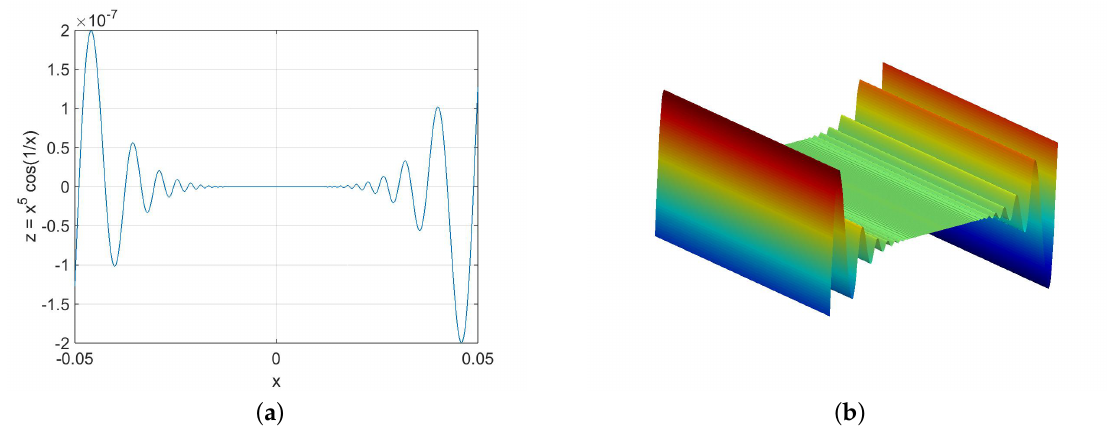
) . An example of a non-Morse function that is not a weak-Morse x ) has infinite critical points in the x ) . The Hessian of z ( x , y ) is singular everywhere in S x